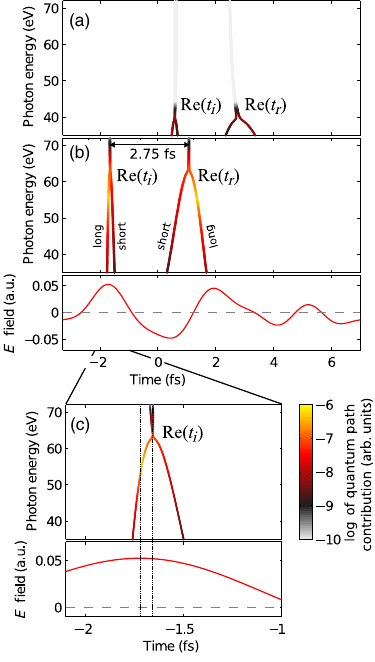
FIG. 5. Results of the saddle point analysis of the Lewenstein model simulations for the parameters of Fig. 2 with ϕ 2 ¼ 1 . 19 π ¼ 1 . 9 π , shown together with the driving waveform on and ϕ CEP the same time axis. In (a) and (b), a full optical cycle of the driving waveform is covered. Two recollision events correspond- ing to HHG emission above 35 eVoccur, shown separately in (a) and (b). Each event is represented by a matching pair of arches, the left and right of which represent the real parts of the ionization and recollision instants of the quantum trajectories, respectively. The left and right branches of the arches of ionization instants, joining at the spectral cutoff, correspond to the long and short trajectory class; the same applies vice versa to the arches of recollision instants. The data points are color coded, showing on logarithmic scale the contribution of the corresponding quantum path to the emitted HHG intensity. Panel (c) shows a zoom onto the ionization instants. The ionizing field strength launching the cutoff trajectories (at right vertical dashed line) is still 99% of its peak value (at left vertical dashed line). While the long trajectories give a higher contribution in this single-atom calculation, phase matching in a macroscopic medium usually leads to a clear dominance of the short-trajectory contribution. Atomic units (a.u.).